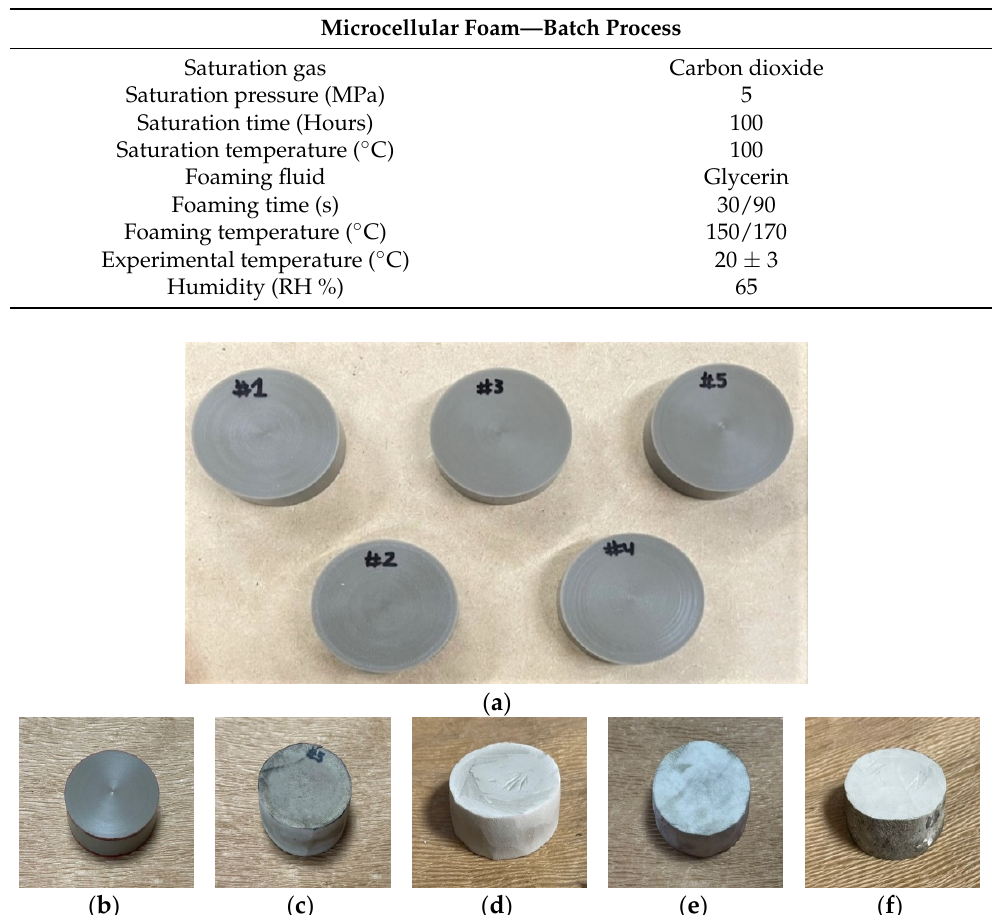
Table 2. Experimental conditions.